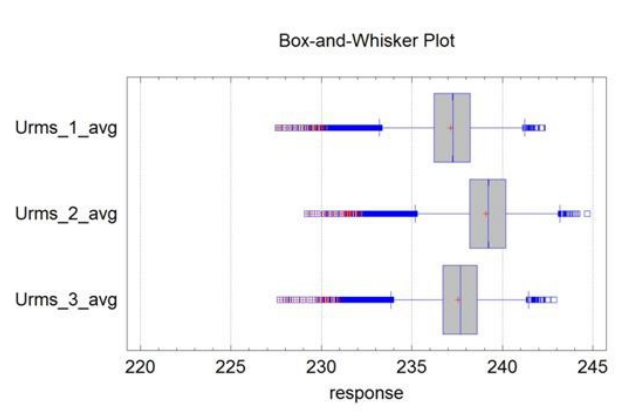
Fig. 8. Box plot of individual phase voltages